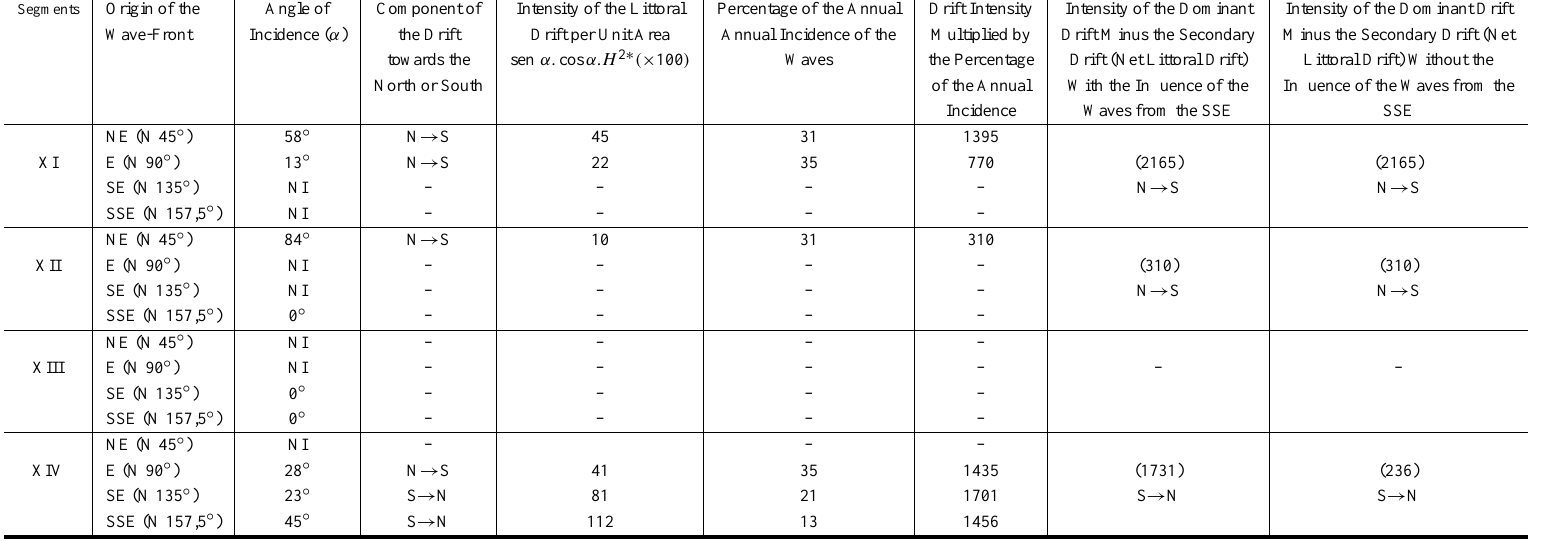
Potential intensity of the net littoral drift for the coastal Segments X through XIV, calculated per unit area, with and without the influence of the SSE waves (See Figs. 5 and 6).